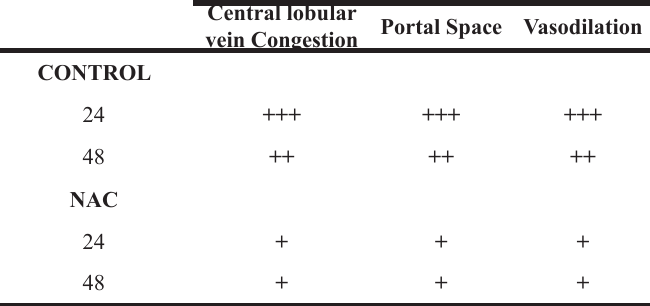
TABLE 1 - Qualitative analysis of liver damage tissue or cell signs found in the slides stained with HE.